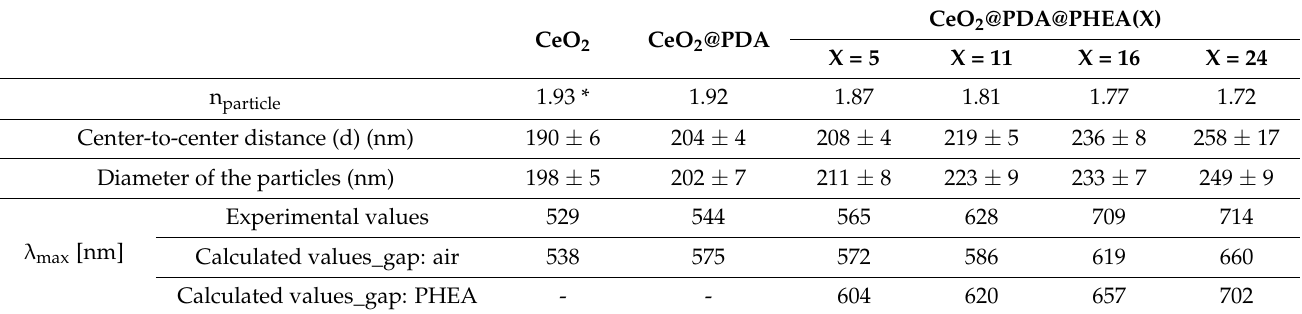
Figure 4. SEM images of pellet samples composed of ( a ) CeO 2 , ( b ) CeO 2 @PDA, ( c ) CeO 2 @PDA@PHEA(5), ( d ) CeO 2 @PDA@PHEA(11), ( e ) CeO 2 @PDA@PHEA(16), ( f ) The insets show photographs of the obtained pellets. ( g ) Reflection spectra for the pellet samples. Table 1. Characterization of pellet samples obtained from the prepared particles.